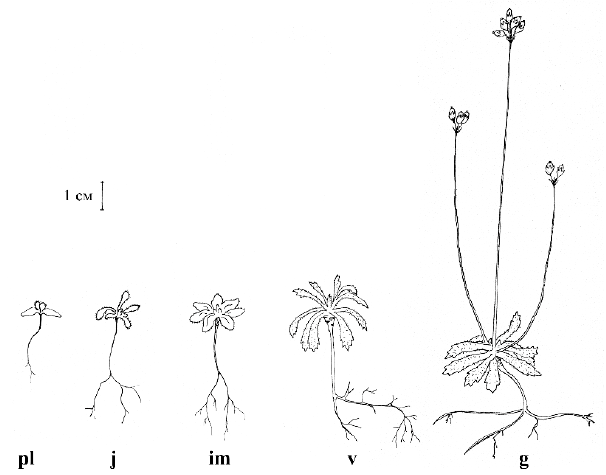
Figure 1. Ontogenetic stages of Androsace albana : pl , seedlings; j , juvenile plants; im , immature plants; v , adult vegetative plants, and g , generative plants, the stages being distinguishable in the field [28].